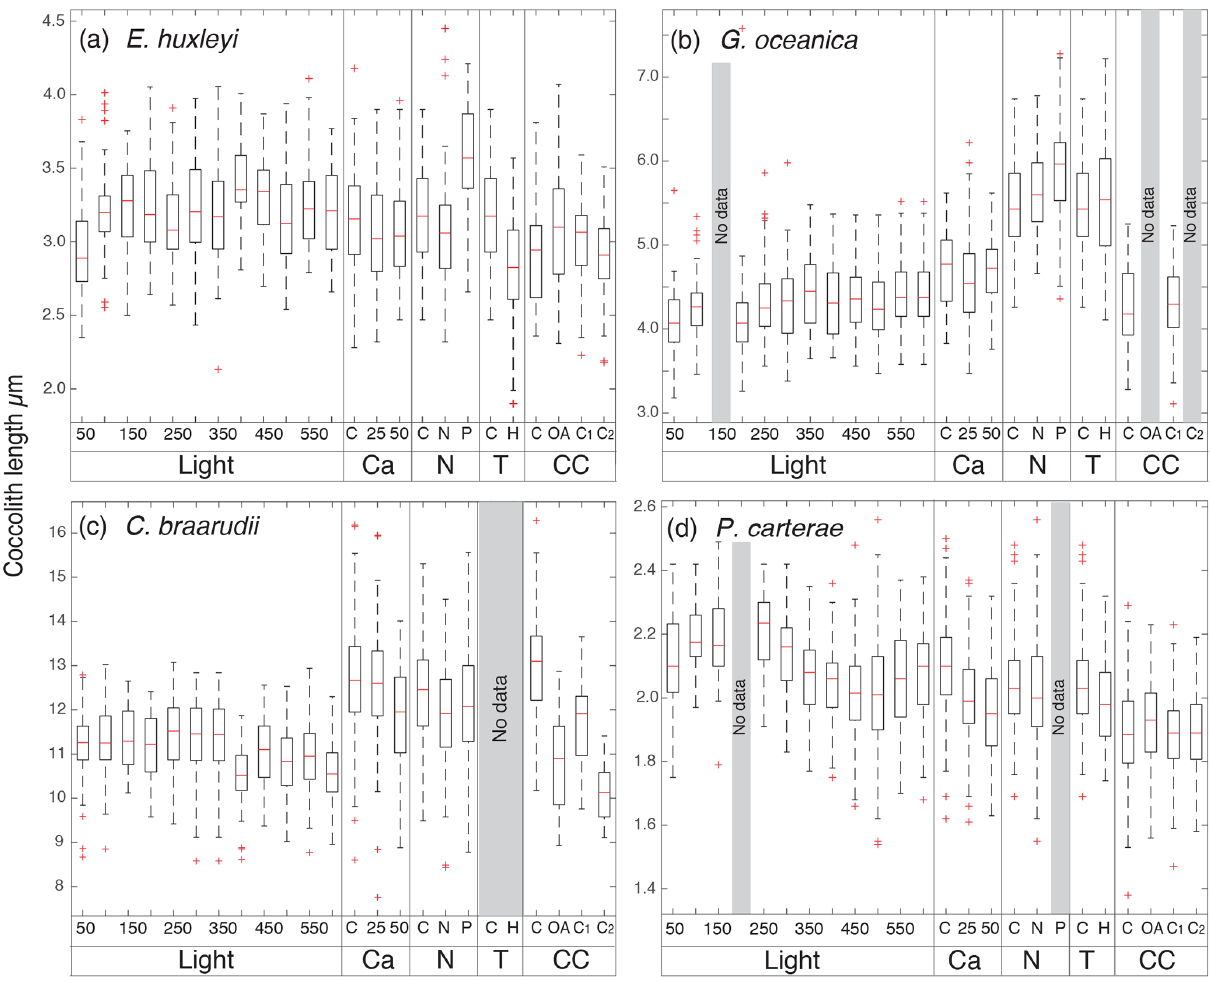
Figure 3. Box plots of coccolith length from the different experiments. In (a) E. huxleyi ; (b) G. oceanica ; (c) C. braarudii ; (d) P. carterae . C: control treatment for every experiment. Light: experiment with 12 different light intensities from 50 to 600µmphotonsm − 2 s − 1 ; Ca: calcium manipulation experiment; 25, [ Ca 2 + ] = 25mmolL − 1 ; 50, [ Ca 2 + ] = 50mmolL − 1 . N: nutrient limitation experiment, N: nitrogen-limited condition; P: phosphate-limited condition. T: temperature experiment; H is for 22.5 ◦ C; CC: carbonate chemistry experiment; theoretical CO 2 values: C: 400ppm; OA, ocean acidification: 1000ppm; C1, Cretaceous scenario1: 1000ppm; C2 Cretaceous scenario2: 3000ppm (for further information see Sects. 2.1.5 and 3.5). The tops and bottoms of each “box” are the 25th and 75th percentiles of the samples respectively. The red line in the middle of each box is the median. The whiskers, extending above and below each box, represent the furthest observations. Observations beyond the whisker length are marked as outliers (red cross). For the light experiment, 50 specimens were considered for every treatment. For Mg / Ca experiment (Ca), nutrient experiment (N), temperature (T), and carbonate chemistry manipulations (CC) experiments, every box plot represents 150 measurements in total (50 measurements for each replicate). The Light experiment was performed in December 2013; the Ca experiment was performed in June 2014; the N experiment was performed in December 2017; the T experiment was performed in October 2017; the CC experiment was performed in August